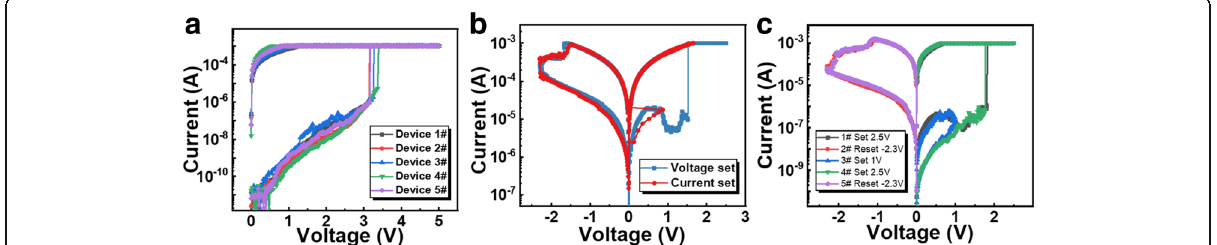
Fig. 4 a Voltage forming of five Ru-based RRAM devices. b Voltage-driven and current-driven set processes in the same RRAM cell. c Incomplete set process with the stop voltage at the bottom of the current